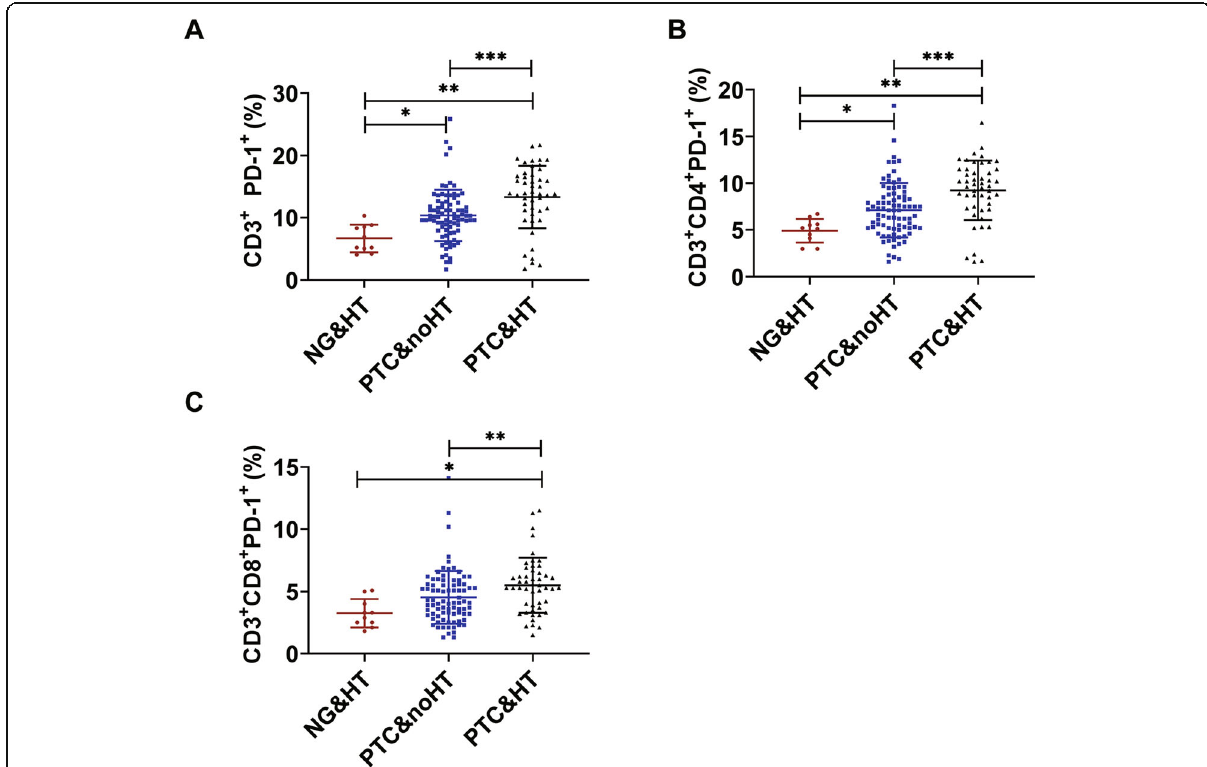
Fig. 2 The activities of PD-1. A. The activities of the CD3 + PD-1+ among NG&HT, PTC&noHT and PTC&HT. B. The activities of the CD3 + CD4 + PD-1+ among NG&HT, PTC&noHT and PTC&HT. C. The activities of the CD3 + CD8 + PD-1+ among NG&HT, PTC&noHT and PTC&HT (* P <